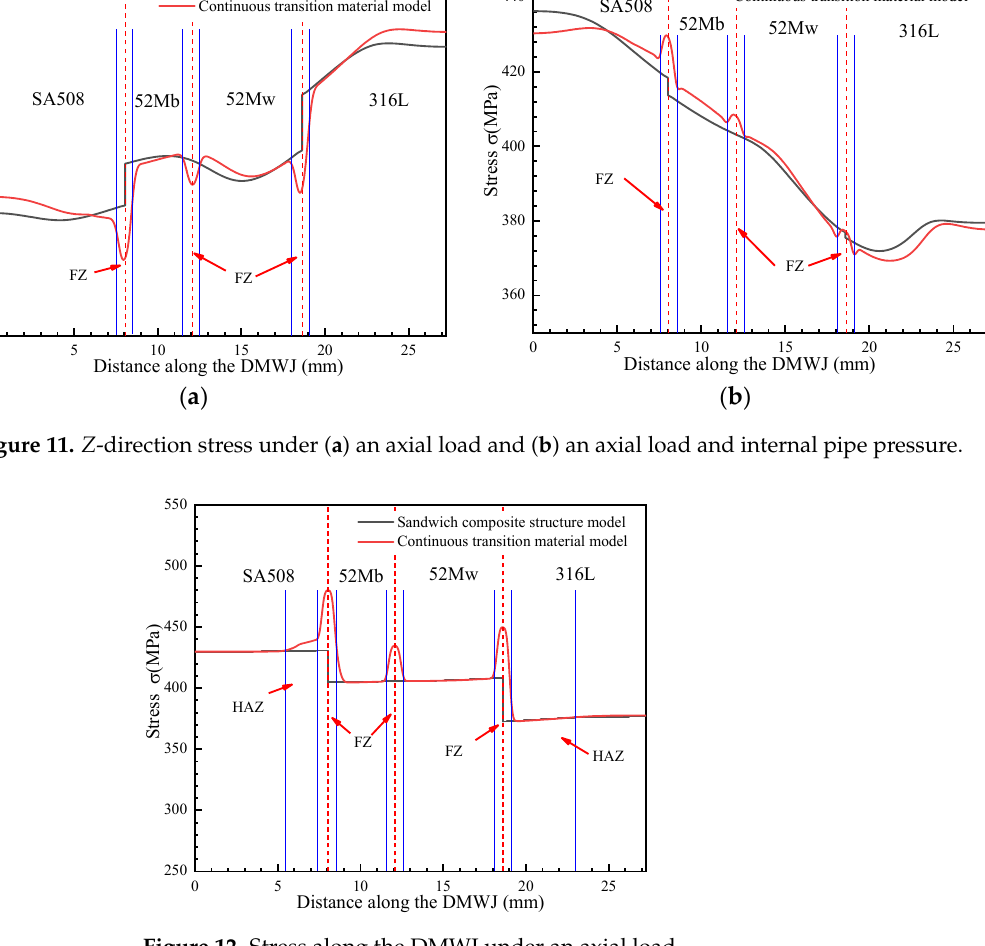
Figure 12, the results upon applying the developed continuous transition model revealed that, in the SA508/52M interface region, the stress gradually increased to 485 MPa before gradually decreasing to 405 MPa, whereas in the 52Mw/316L interface region, the stress gradually increased to 450 MPa before gradually decreasing to 376 MPa. In the sandwich structure model, the stress values did not transition continuously in the interface region but Figure 10. Y -directional stress under ( a ) an axial load and ( b ) an axial load and internal pipe pressure. instead changed abruptly. This was evident in the sudden stress changes (from 430 MPa to 404 MPa in the SA508/52Mb interface region and from 404 MPa to 377 MPa in the As shown in Figure 11, under an axial load, the sandwich structure model showed a 52Mw/316L interface region). For an internal pressure of 100 MPa, the analysis method significant increase in stress at the SA508/52M and 52M/316L interfaces. For an internal was the same. In addition, the method proposed in this study can characterize the variation pressure loading, the opposite trend was observed and a sudden change in stress occurred of mechanical properties between overlay layers composed of 52Mb and 52Mw. Thus, the at the interface region. The continuous transition model eliminated abrupt changes in method proposed herein is more appropriate for expressing the mechanical properties in stress, allowing for a continuous transition in the mechanical properties of the materials the interface region and better for assessing the structural integrity of DMWJs. in the interface regions.